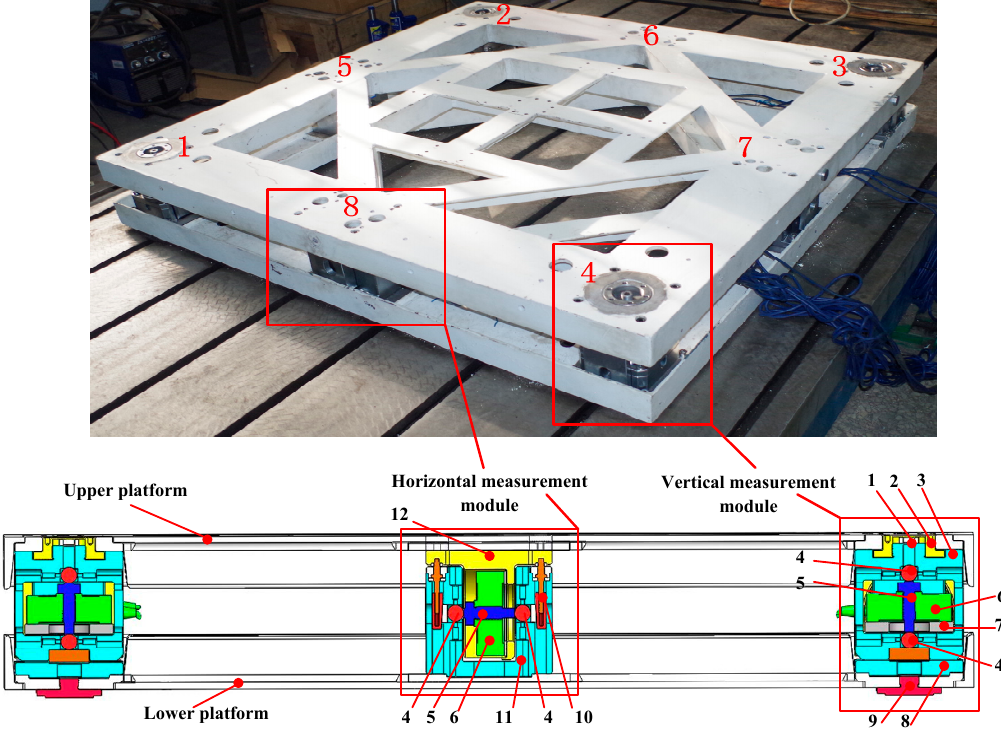
Figure 2. Proposed bidirectional-decoupling over-constrained six-dimensional force sensor. Table 1 lists the labelled parts in Figure 2. Table 1. Labelled parts of the six-dimensional force sensor.